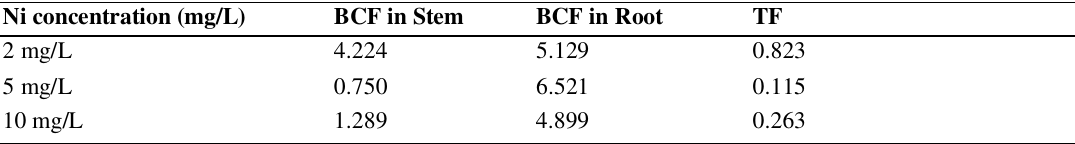
BCF and TF of Ni in the Iresine herbstii after 21 days of